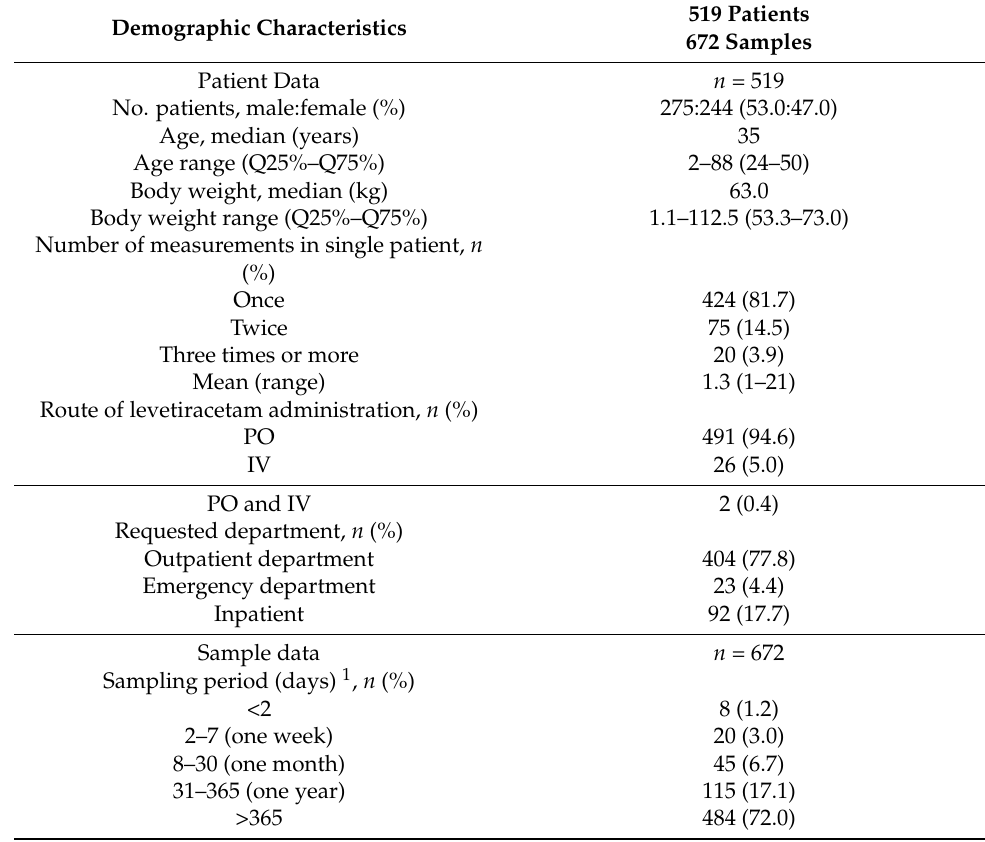
Table 1. Demographic and descriptive data.